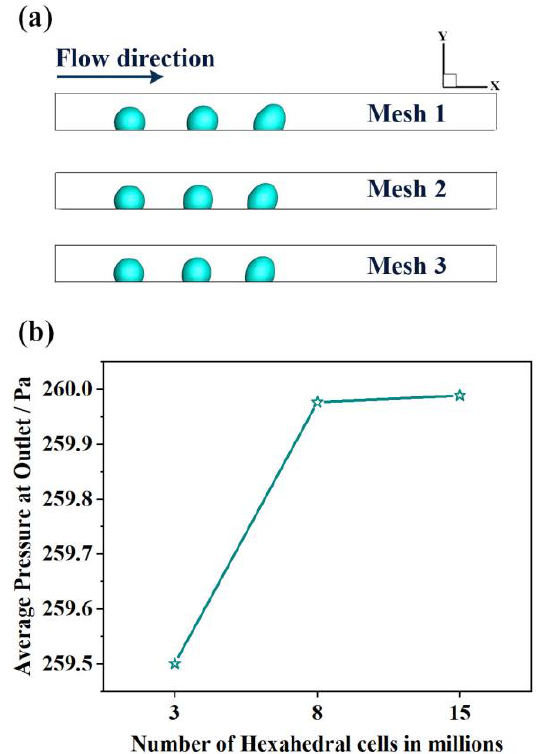
Figure 4. Grid independence validation test. ( a ) Spatio-temporal position of the droplet; ( b ) the average pressure at channel outlet for different mesh numbers.